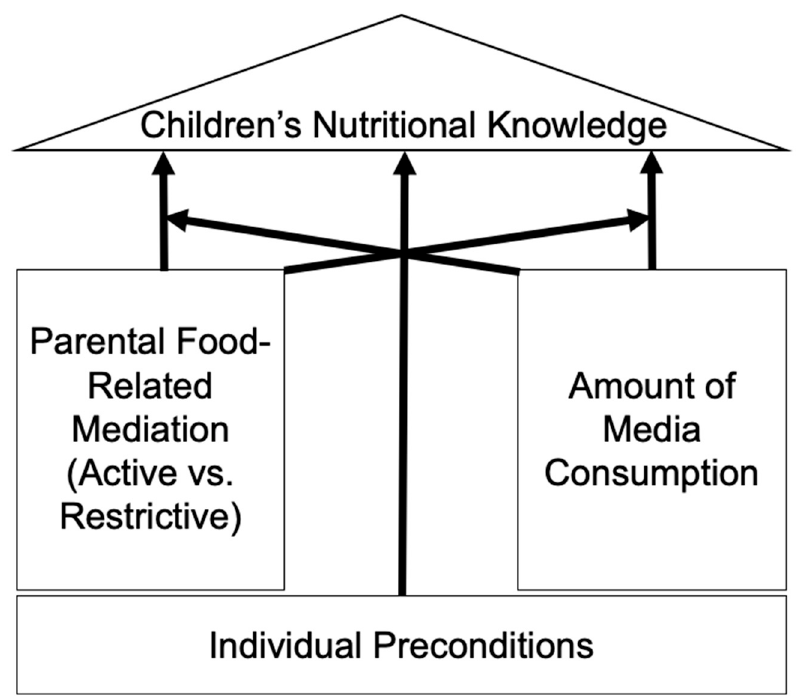
Figure 1. Conceptual model.